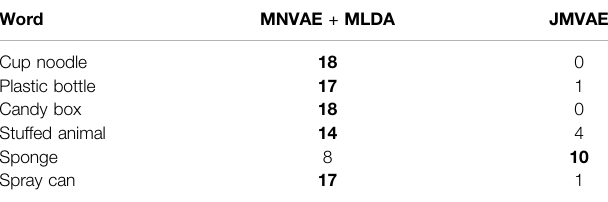
TABLE 3 | Results of subjective evaluation of generated images. This table indicates the number of subjects who selected each method as generating more appropriate images representing the word.